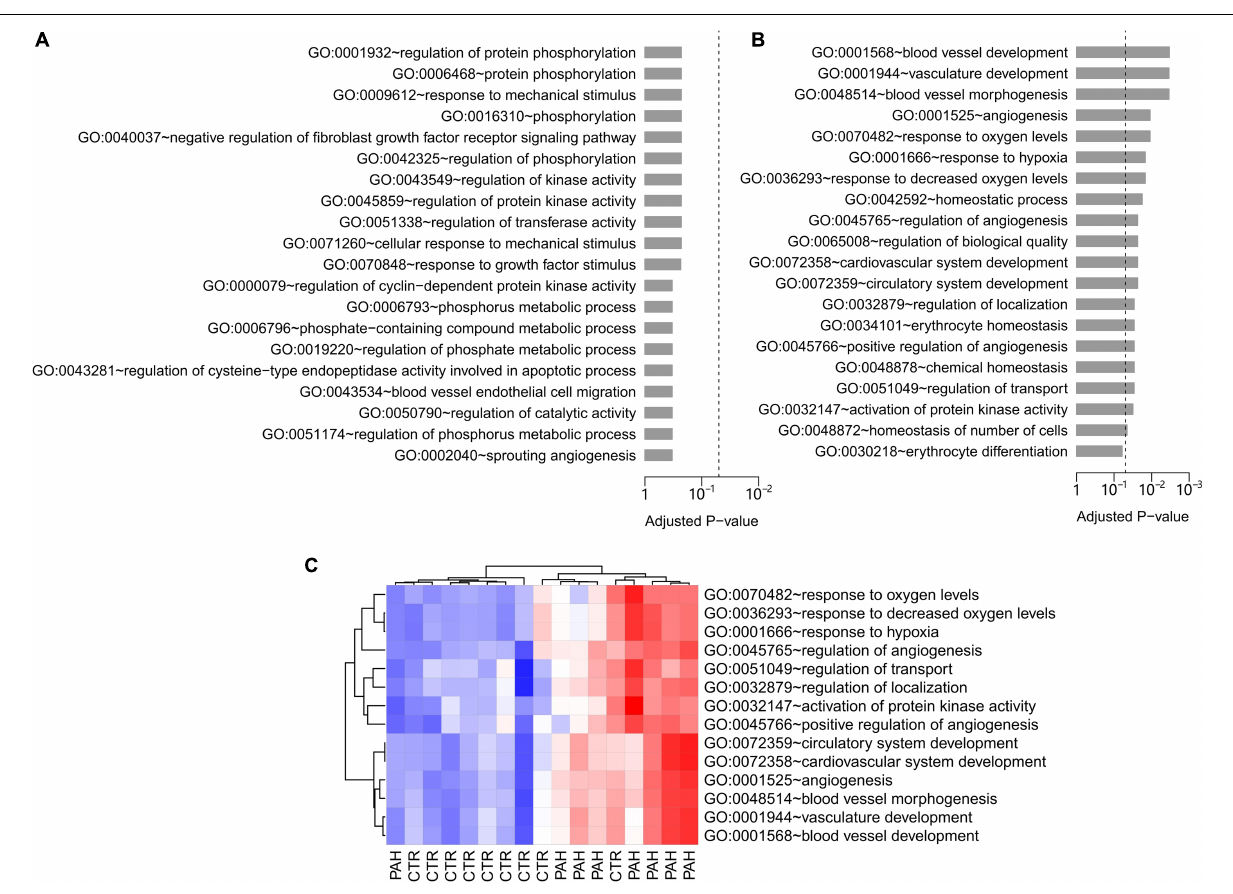
FIGURE 1 | GO biological process analysis in Hif2a -KD VHL-deficient human ccRCC cells and PAH patients. (A) The top 20 GO biological process terms associated with the genes up-regulated in Hif2a -KD VHL-deficient human ccRCC cells. Fisher’s exact test was adopted to calculate the P -values which was then corrected by Benjamini-Hochberg procedure. The significance level of 0.05 was denoted by the dash line. (B) The top 20 GO biological process terms associated with the genes down-regulated in Hif2a -KD cells. The P -values were calculated by Fisher’s exact test and corrected by Benjamini-Hochberg procedure. The dash line denotes the significance level of 0.05. All the GO gene sets listed are statistically significant except the last term, “GO:0030218 ∼ erythrocyte differentiation.” (C) Gene set score heatmap of the HIF2 α -mediated GO biological process terms in human lungs. In total, 14 GO terms up-regulated in lung tissues from PAH patients were listed. Red and blue represent relative up-regulation and down-regulation of gene expression, respectively.